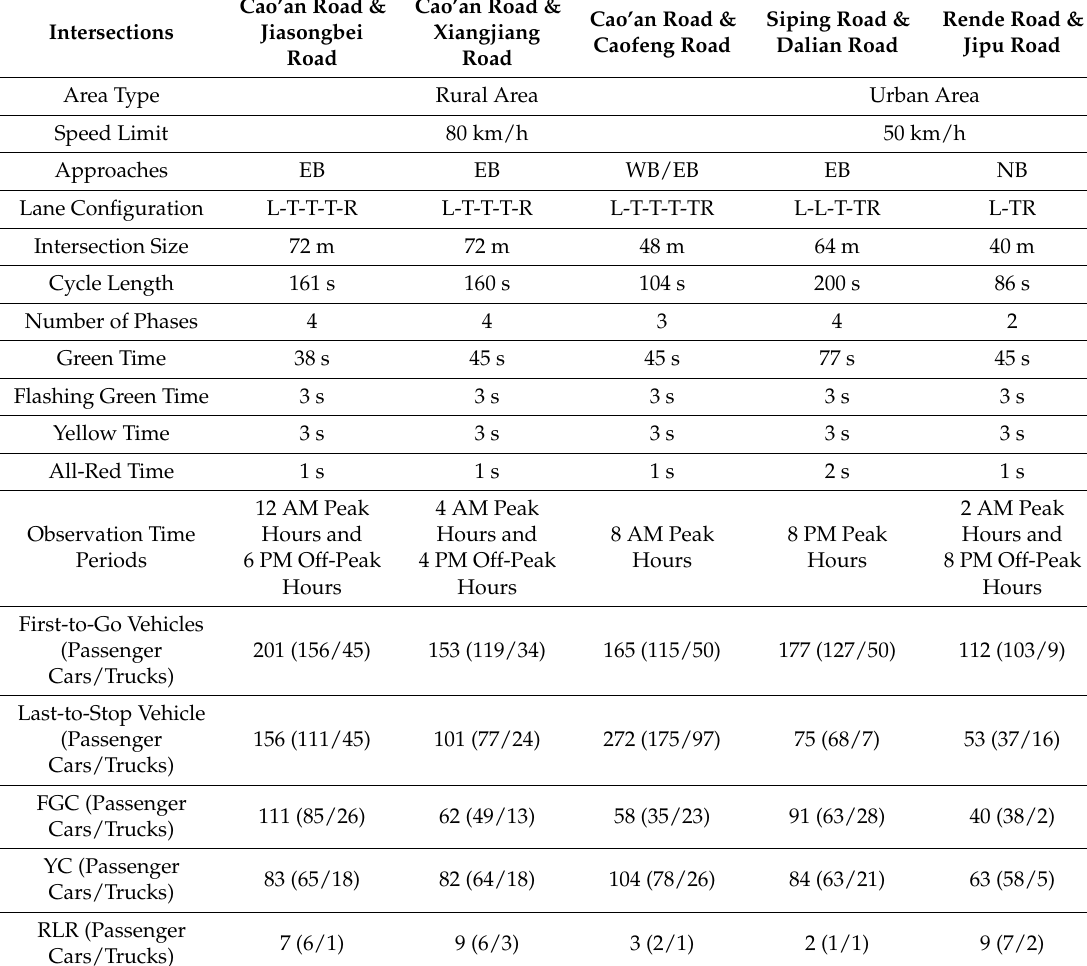
Table 1. Summary of site conditions at the observed intersections and